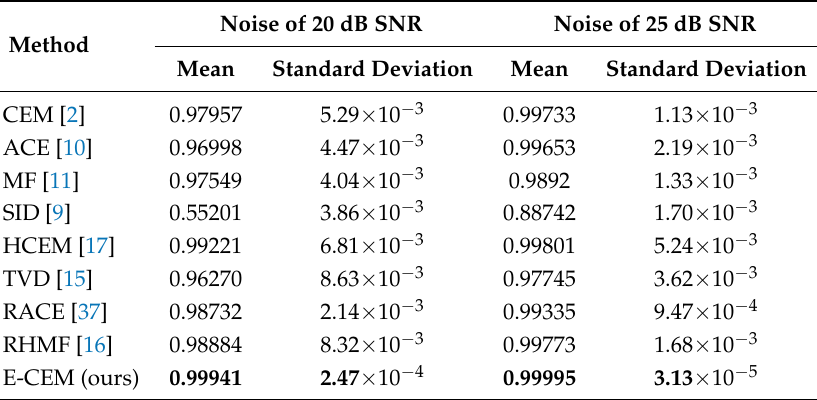
Figure 7. ROC curves of different detection algorithms on our synthetic hyperspectral data (with noise of 20dB SNR): CEM [2], ACE [10], MF [11], SID [9], HCEM [17], TVD [15], RACE [37], RHMF [16] and the proposed E-CEM. Table 1. The mean and standard deviation of the area under the ROC curve of different algorithms on synthetic data under the interference of white Gaussian